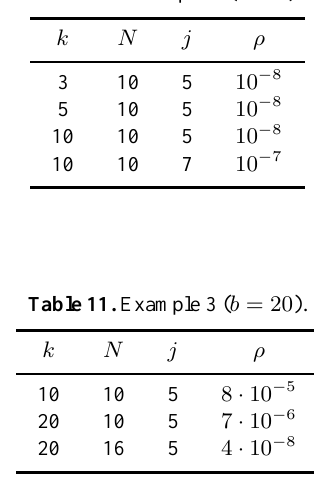
Table 10. Example 3 ( b = 1 ).